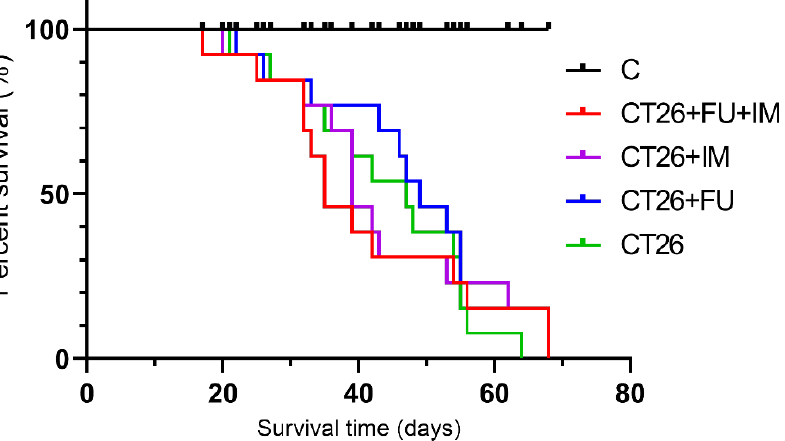
Figure 2. Effect of the treatments on animal survival. Kaplan-Meier survival curves ( n = 15) were compared using the log-rank test (Mantel-Cox); No significant difference in lifespan was observed between treated CT26 mice p = 0.0312 (CT26 vs. CT26 + IM), p = 0.0019 (CT26 vs. CT26 + 5-FU), p < 0.0007 (CT26 vs. CT26 + IM + 5-FU); C, untreated control; IM, IM treatment; CT26, tumour control; CT26+ IM, CT26 treated with IM; CT26 + 5-FU, CT26 treated with 5-FU; CT26 + IM + 5-FU, CT26 treated with IM and 5-FU.